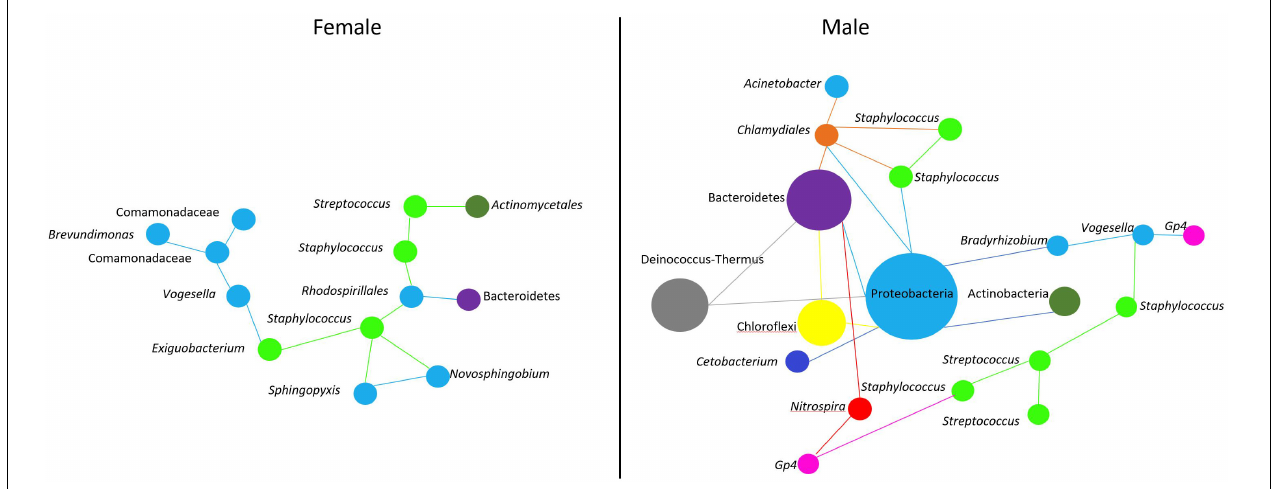
FIGURE 6 | Predicted association of Streptococcus and Staphylococcus in the buccal cavity of female and male Nile tilapia. In females, we find a single cluster ( Figure 5A ) of microbe-microbe interaction. While in males, microbe interactions are complex ( Figure 5C ). Bacteria belonging to a particular phylum are color coded. The size of the nodes are based on the abundance of the